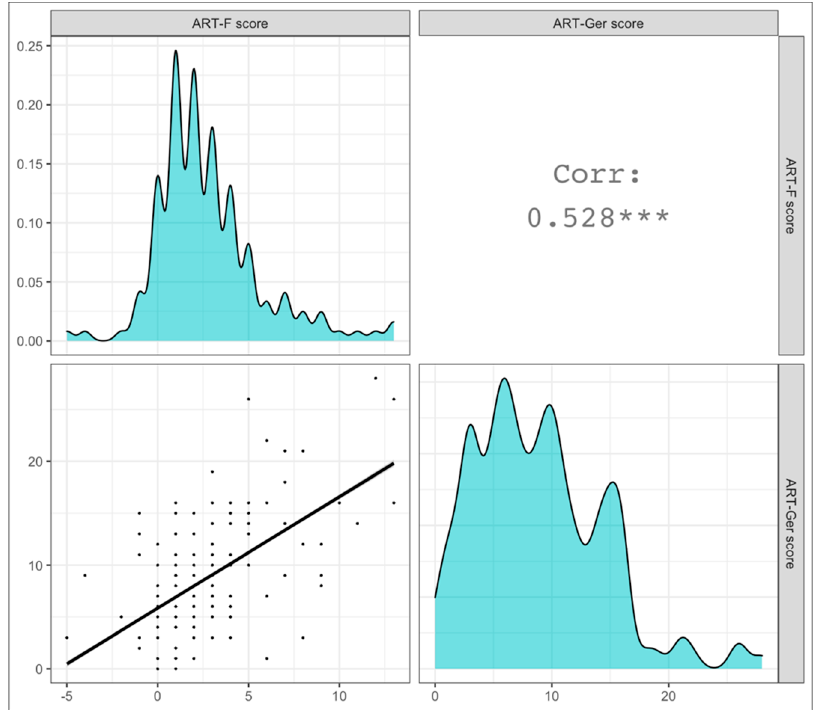
Figure 7. Correlations matrix: Spearman’s test of correlations of ART-F and ART-Ger scores by non-native speakers (Signif. code: “***” < 0.001).